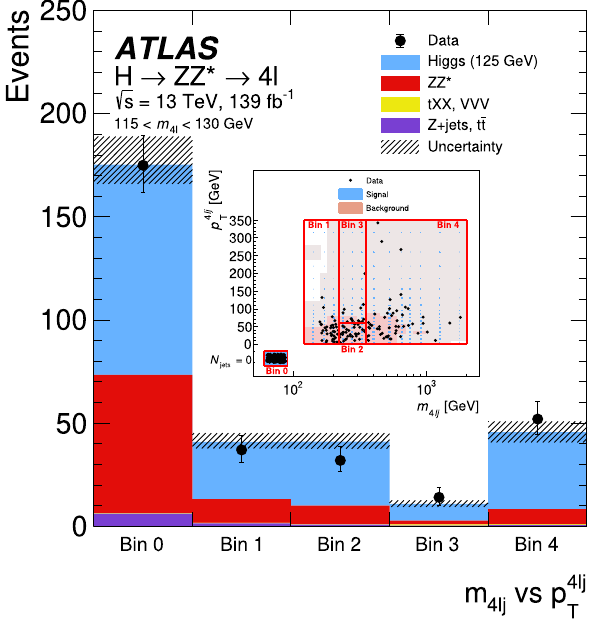
Fig. 12 The observed and expected (pre-fit) distribution in bins of the Fig. 13 The observed and expected (pre-fit) distribution in bins of the leading vs. subleading Z boson mass, m 12 vs. m 34 . The same distri- transverse momentum of the four-lepton plus leading-jet system vs. bution in the 2D plane is provided in the inset plot, where the black the invariant mass of the four-lepton plus leading-jet system, p 4 dots depict data and the blue and pink shaded areas represent simulated m 4 (cid:3) j . The same distribution in the 2D plane is provided in the inset signal and background, respectively. The red lines depict the bin bound- plot, where the black dots depict data and the blue and pink shaded aries, chosen as described in Sect. 7. These distributions correspond to areas represent simulated signal and background, respectively. The red the mass region 115 < m 4 (cid:3) < 130 GeV for an integrated luminosity of √ lines depict the bin boundaries, chosen as described in Sect. 7. These s = 13 TeV. A SM Higgs boson signal with a 139 fb − 1 collected at distributions correspond to the mass region 115 < m 4 (cid:3) < 130 GeV mass m H = 125 GeV is assumed. The uncertainty in the prediction is for an integrated luminosity of 139 fb − 1 collected at shown by the hatched band, which includes the theoretical uncertainties A SM Higgs boson signal with a mass m H = 125 GeV is assumed. of the SM cross section for the signal and the Z Z ∗ background The uncertainty in the prediction is shown by the hatched band, which includes the theoretical uncertainties of the SM cross section for the signal and the Z Z ∗